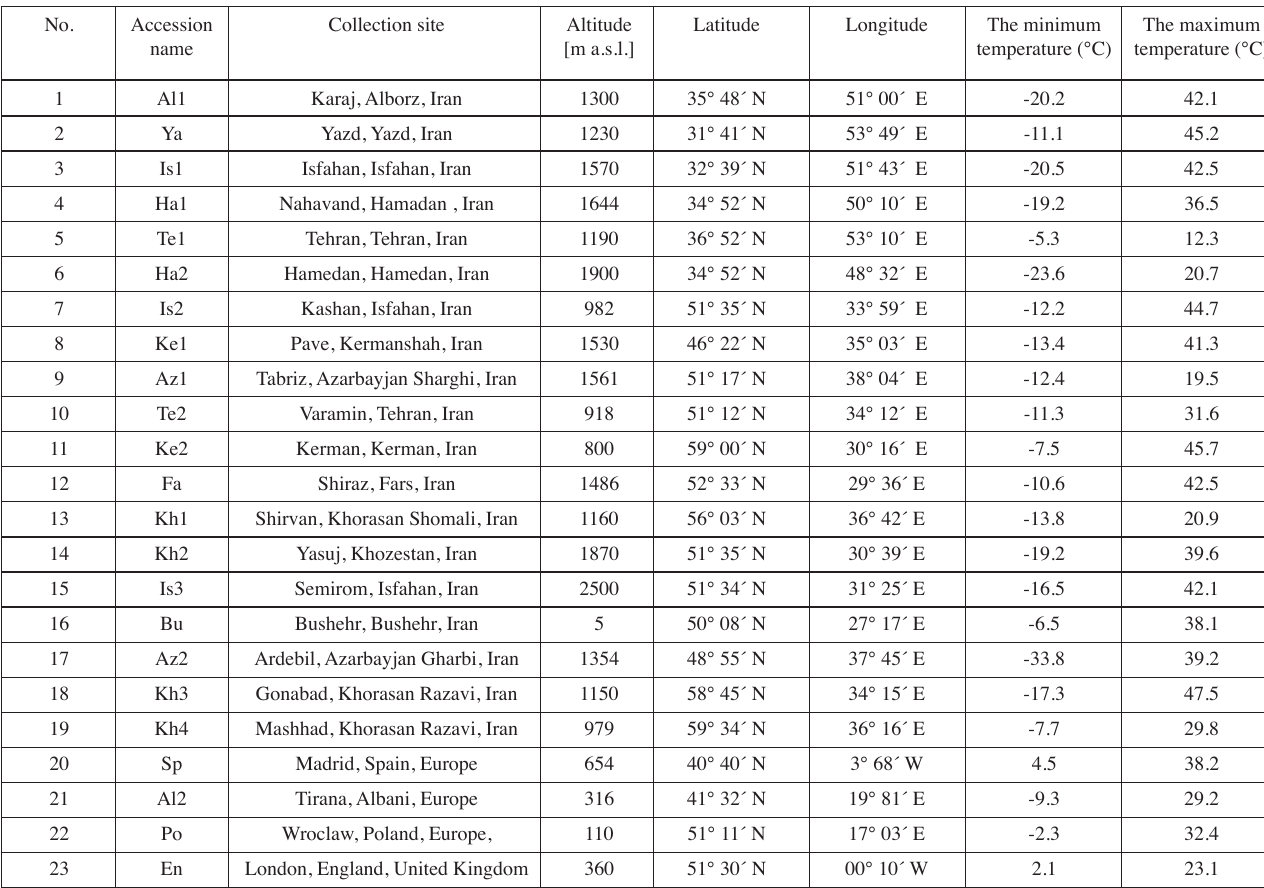
Tab. 1: Collection site and geographical characteristics of different fennel